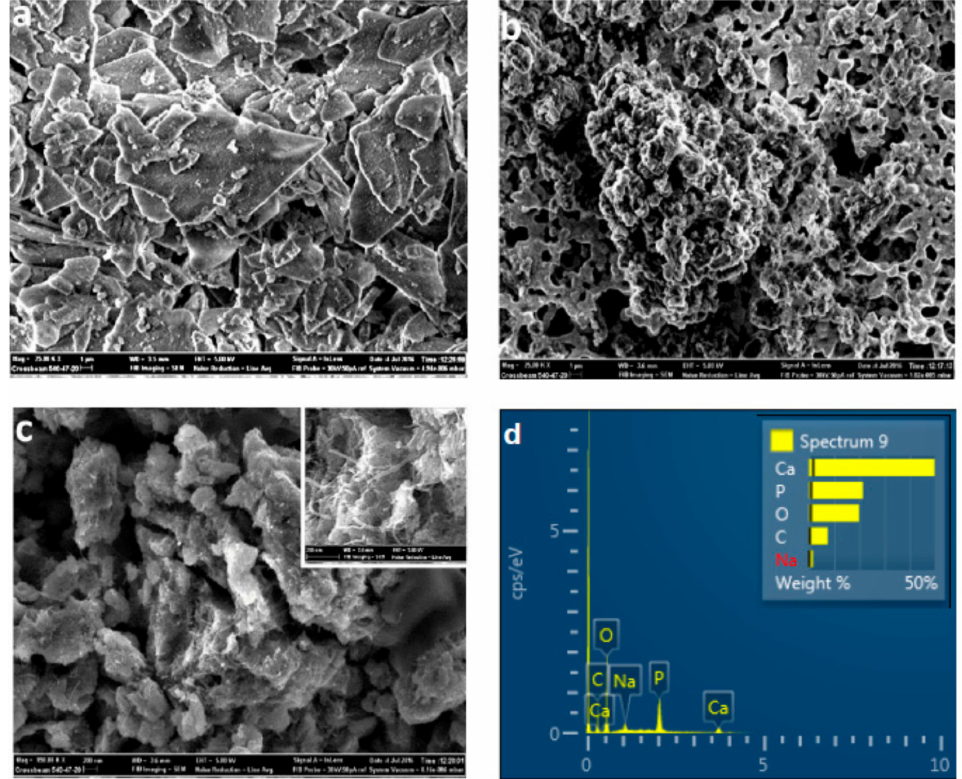
Figure 3. SEM images of ( a ) pure HA and ( b and c ) HA-GN-MWCNT. ( d ) EDX analysis of the HA-GN-MWCNT composite